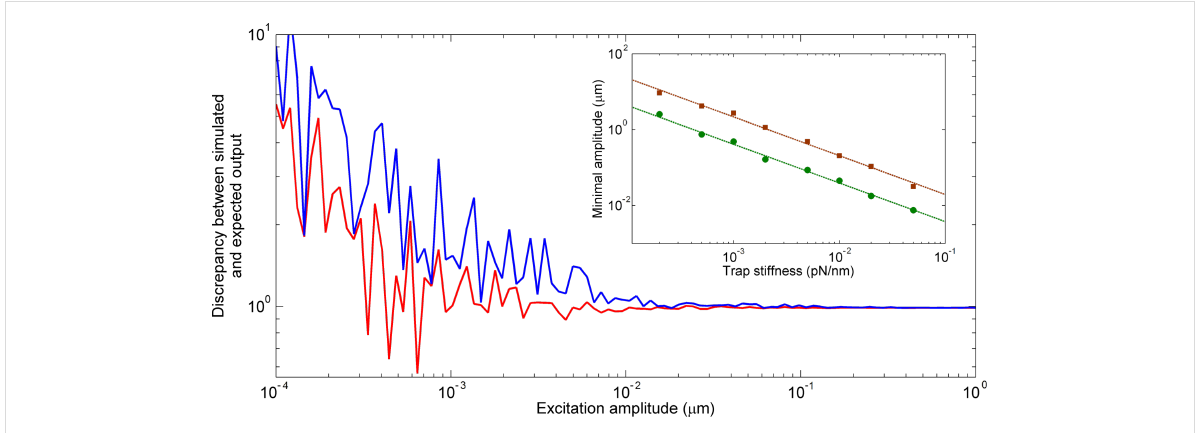
Figure 1: Simulations of the accuracy of the lock-in method. The red line shows the ratio between expected oscillation amplitude and simulated ampli- tude in the presence of 1% noise. In the case when the expected and simulated amplitudes match, the ratio converges to one. Other values show a misleading amplitude due to a SNR that is too high. With the used parameters the ratio increases for oscillation amplitudes smaller than 10 − 2 μ m. The blue line depicts the 5% deviation with 3 σ accuracy. Inset: Minimal detectable amplitude, when the calculated amplitude is in the range of 1% (brown) and 5% (green) compared to the expected one (with 3 σ